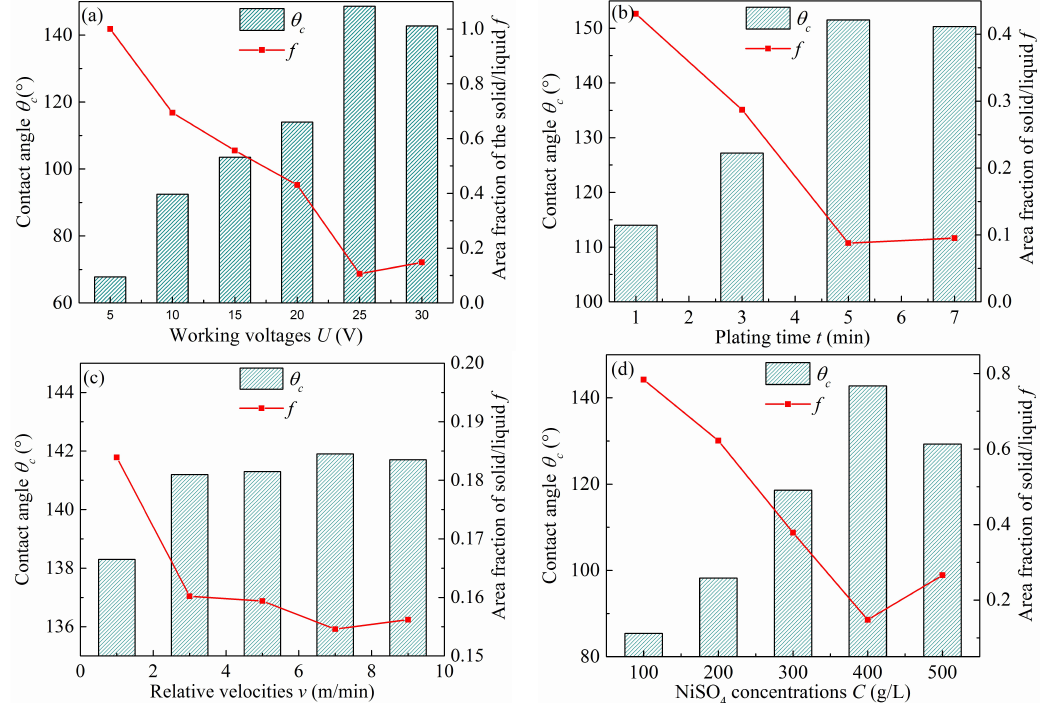
Figure 3. Contact angles and solid–liquid area fraction of Ti6Al4V alloy surfaces at different process parameters, such as ( a ) working voltage, ( b ) plating time, ( c ) relative velocity, and ( d ) NiSO 4